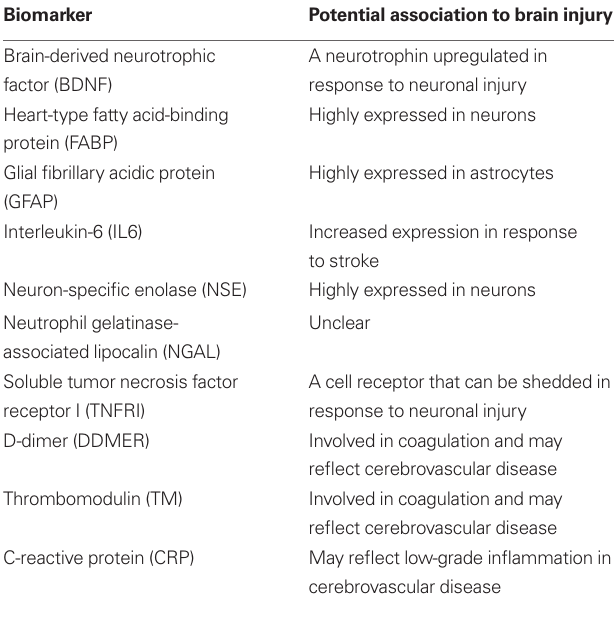
Table 2 | Summary of tested candidate